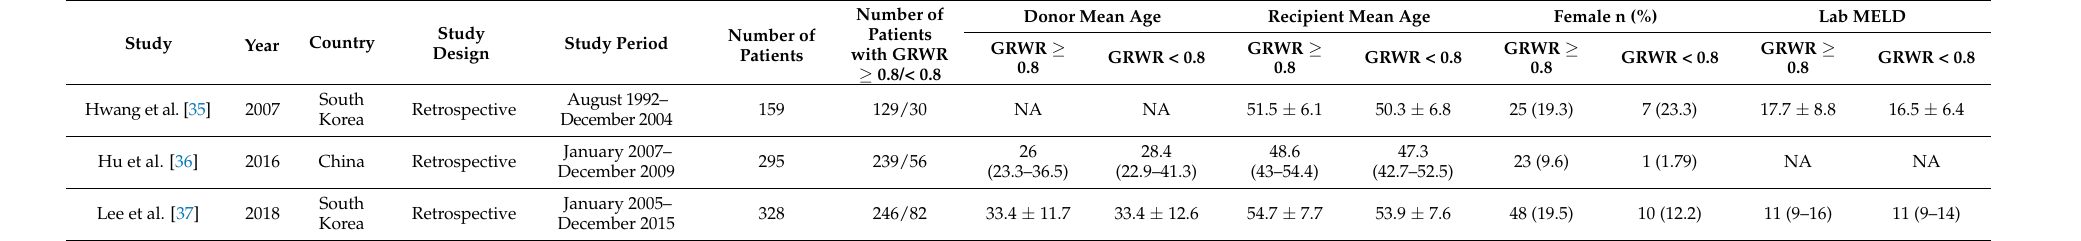
Table 2. Characteristics of the included studies and patients.